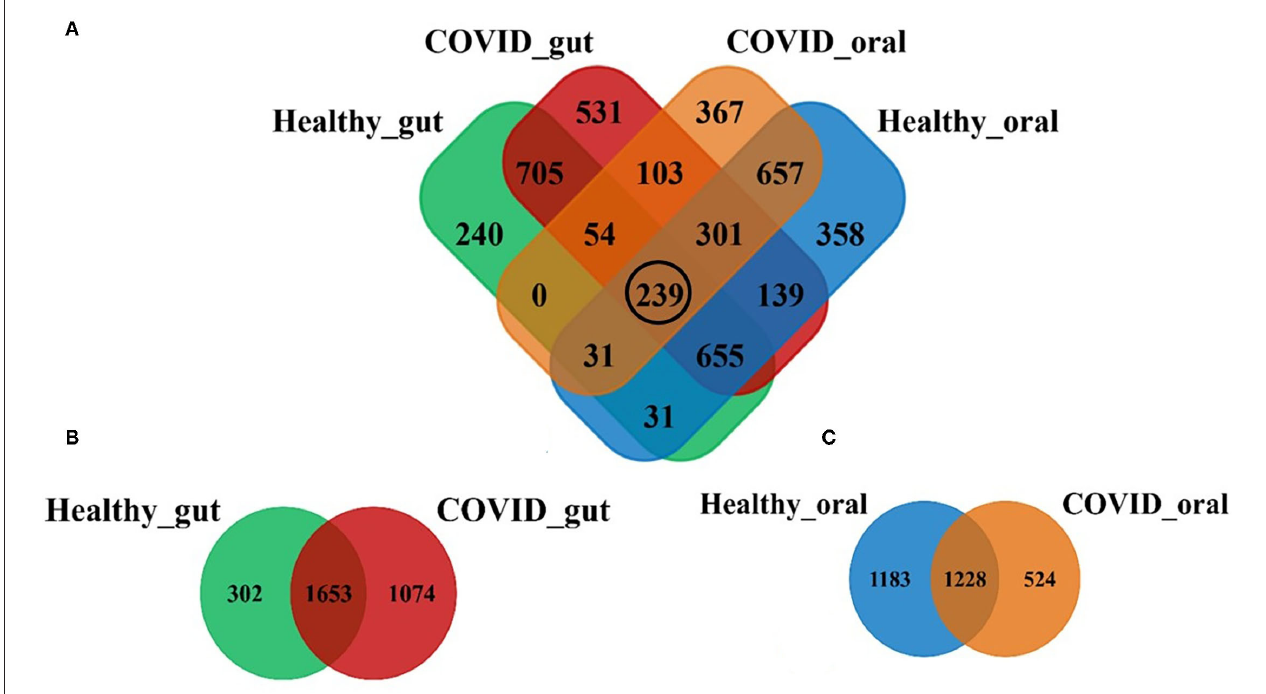
FIGURE 1 | Distribution of shared and unique operational taxonomic units (OTUs) in the gut and oral wash of healthy controls and COVID-19 cases. (A) Venn diagram showing the overview of common and unique OTUs among four groups of samples. The black circle indicates the number of OTUs shared to all groups. (B,C) Represents the distribution of OTUs between healthy and COVID-gut, and healthy and COVID-oral samples, respectively.